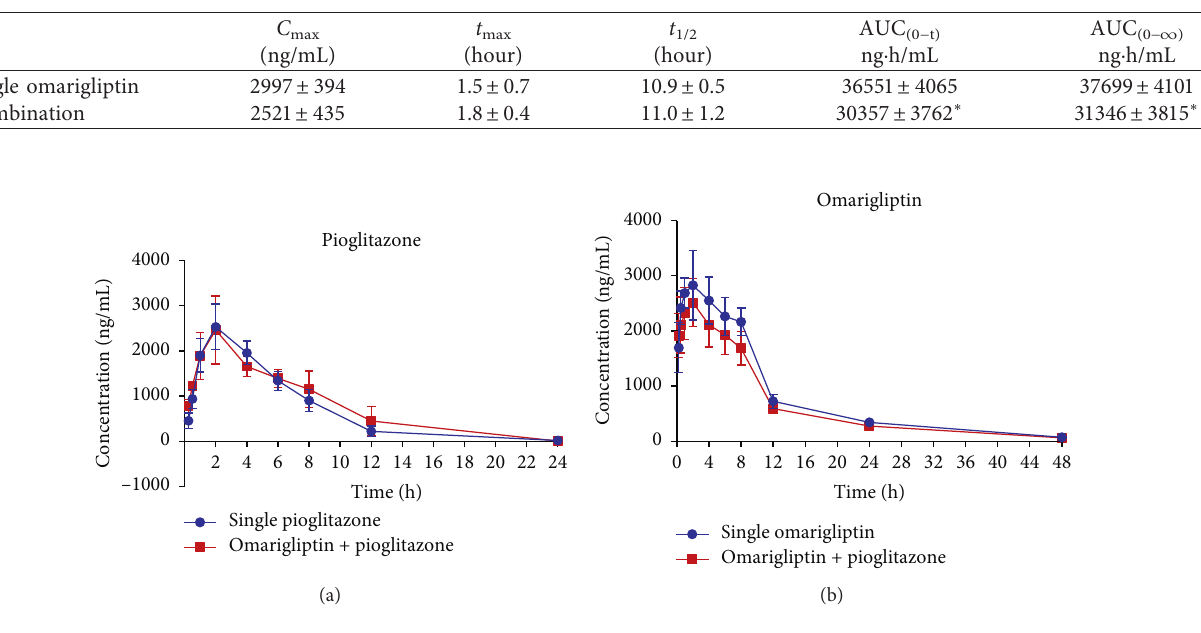
Table 8: Pharmacokinetic parameters of omarigliptin in rats after single or combination administration ( n � 5).